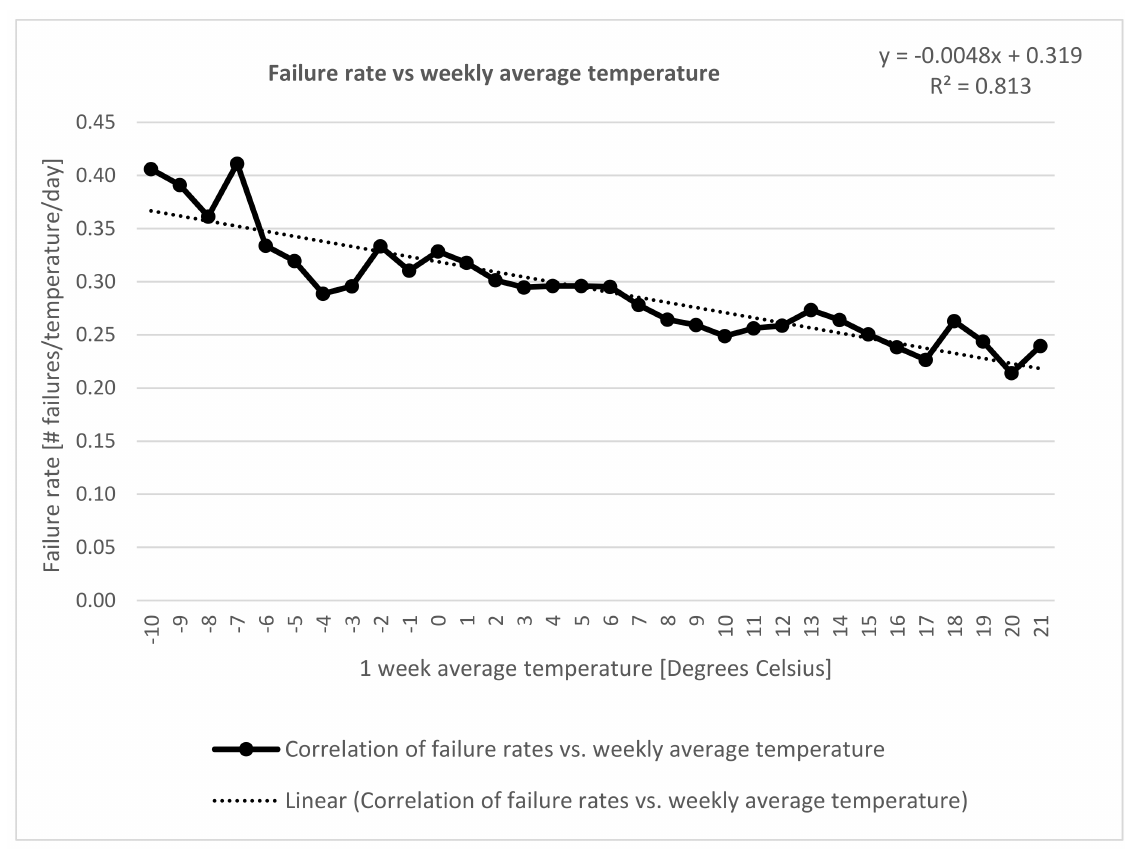
Figure 6. Linear regression showing the correlation between failure rates and average temperature the preceding